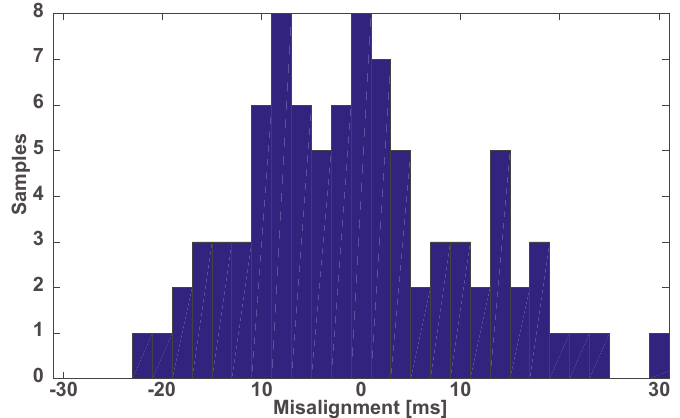
Figure 2. Misalignment caused by the Doppler shift.